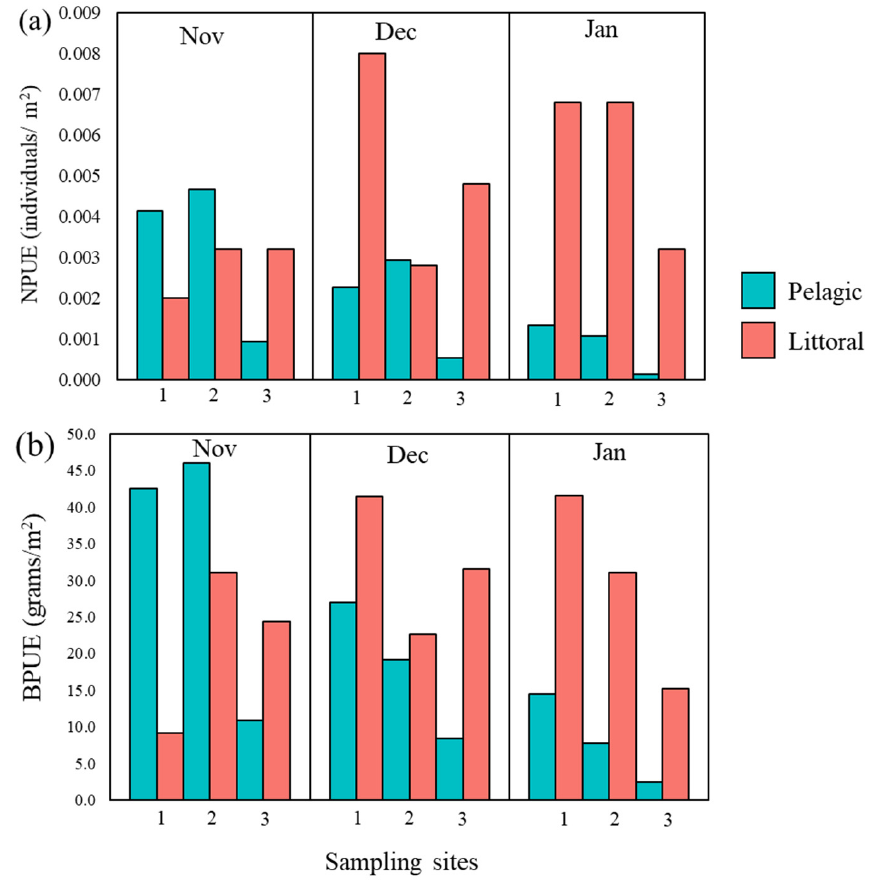
Figure 3. Distribution of ( a ) Number (NPUE) and ( b ) Biomass (BPUE) of catfish across site and divided per habitat type (bar color) and each month of capture.